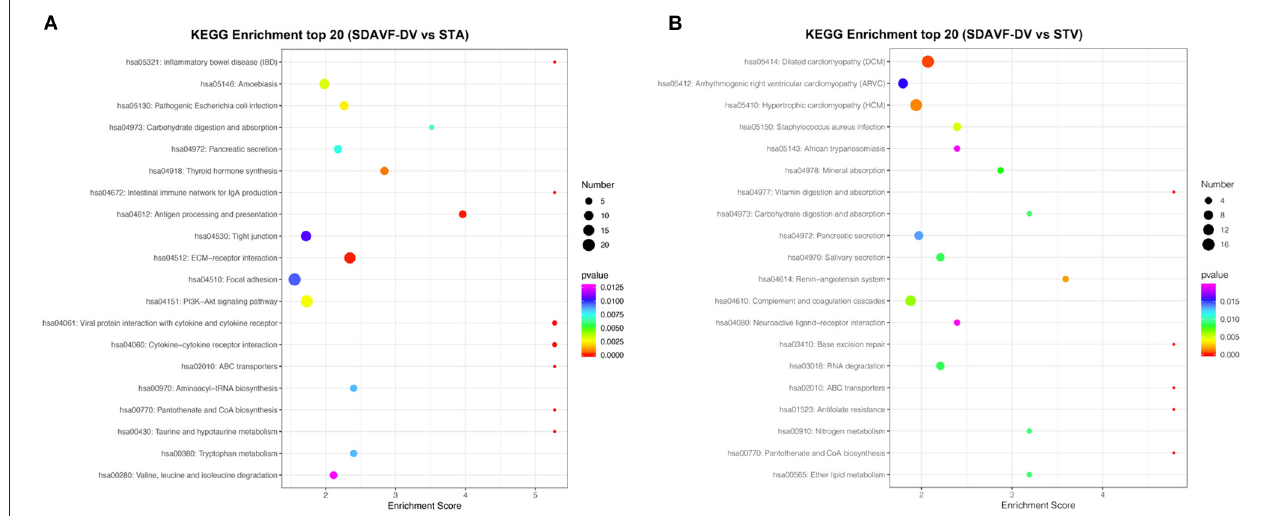
FIGURE 6 | KEGG pathway analysis. The bubble chart shows the KEGG pathway analysis of the top 20 differentially expressed genes when comparing the SDAVF-DV with the STA (A) and STV (B)